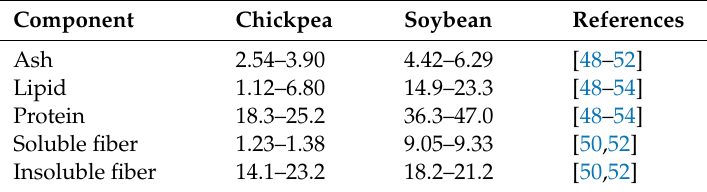
Table 1. Proximate composition (g / 100 g) of chickpea and soybean. Component Chickpea